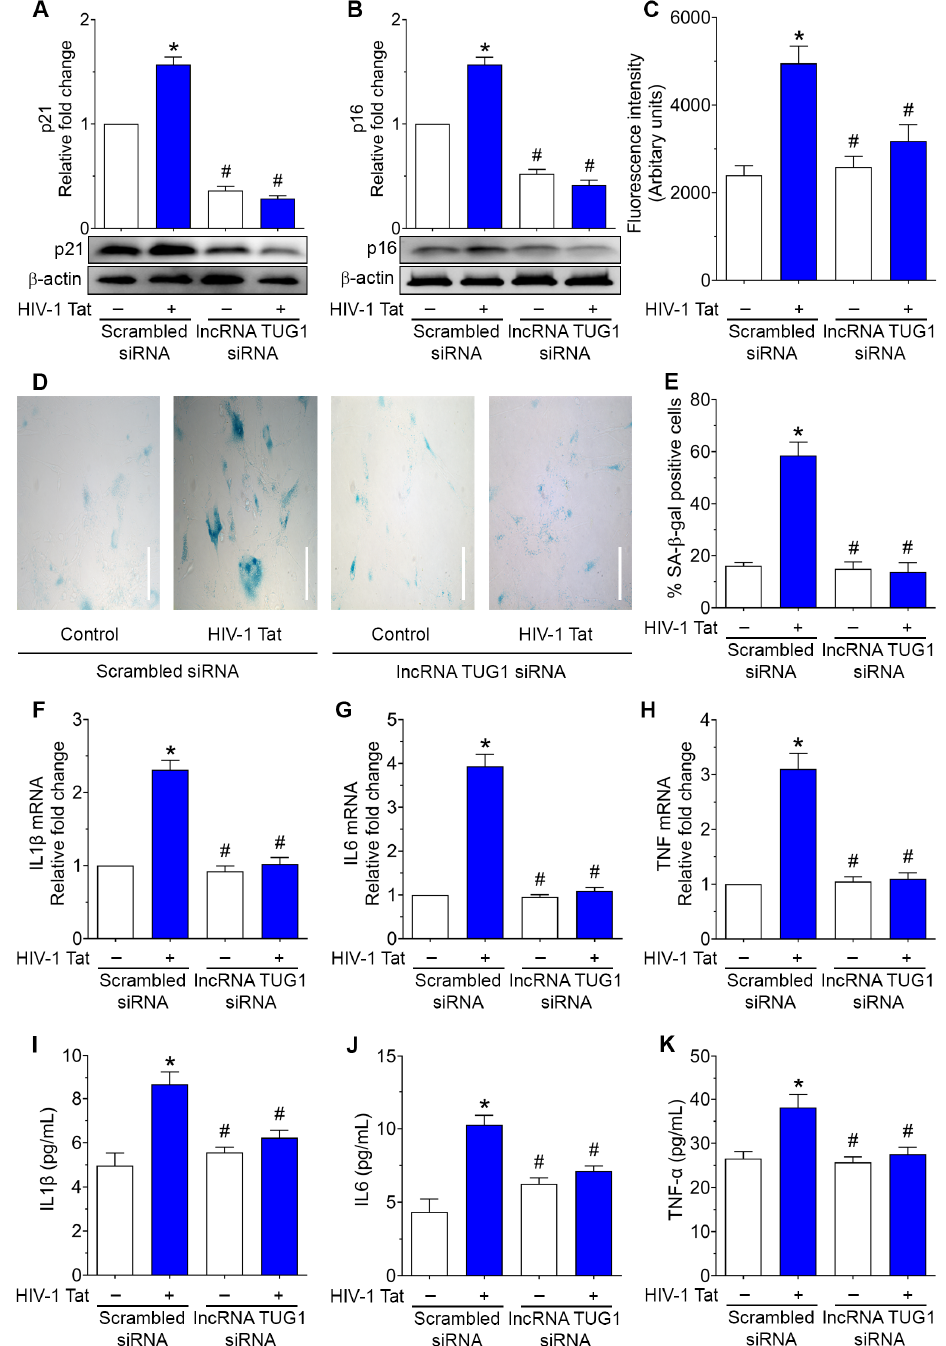
Figure 3. Gene silencing of lncRNA TUG1 prevented HIV-1 Tat-induced cellular senescence in HPAs. Representative western blotting showing the expression levels of p21 ( A ) and p16 ( B ) in HPAs transfected with siRNAs of scrambled and lncRNA TUG1 followed by HIV-1 Tat exposure. β -actin was used as an internal control for all experiments. ( C ) Bar graph showing the ROS production levels in HPAs transfected with siRNAs of scrambled and lncRNA TUG1 followed by HIV-1 Tat exposure. Representative SA- β -gal staining ( D ) and quantification ( E ) in HPAs transfected with siRNAs of scrambled and lncRNA TUG1 followed by HIV-1 Tat exposure. Scale bar: 100 µ m. qPCR showing the mRNA expression of proinflammatory cytokines, such as IL1 β ( F ), IL6 ( G ), and TNF ( H ) in HPAs transfected with siRNAs of scrambled and lncRNA TUG1 followed by HIV-1 Tat exposure. GAPDH was used as a housekeeping control. ELISA quantification showing the protein levels